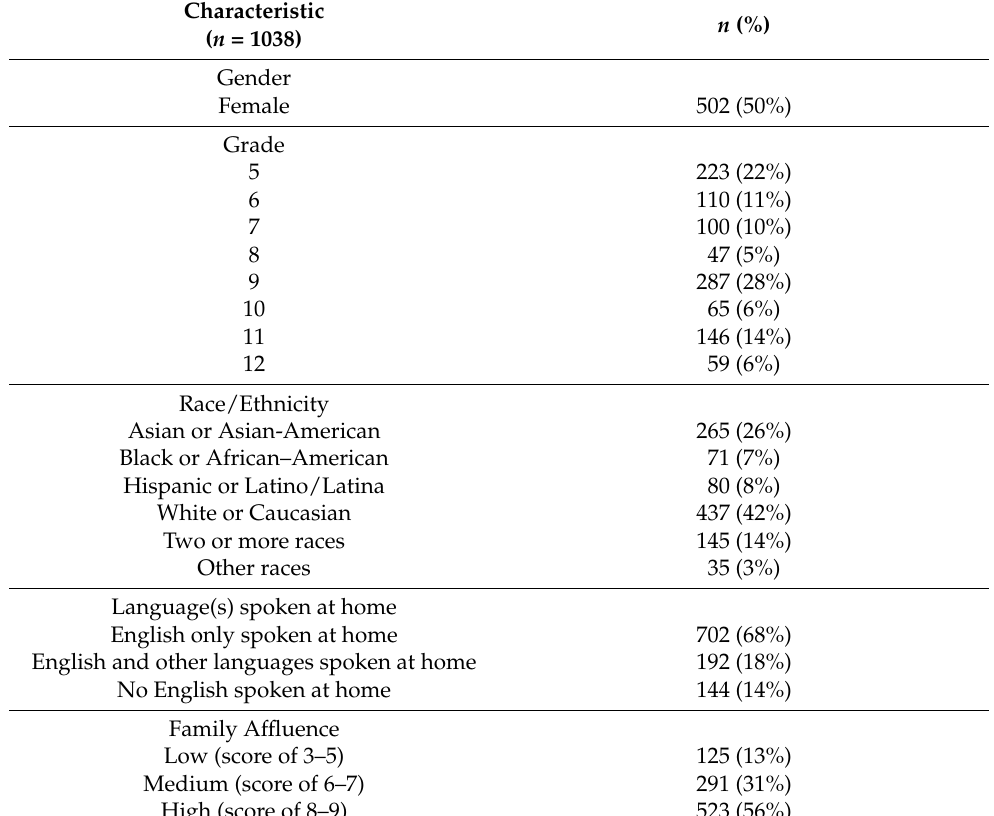
Table 1. Participant characteristics.